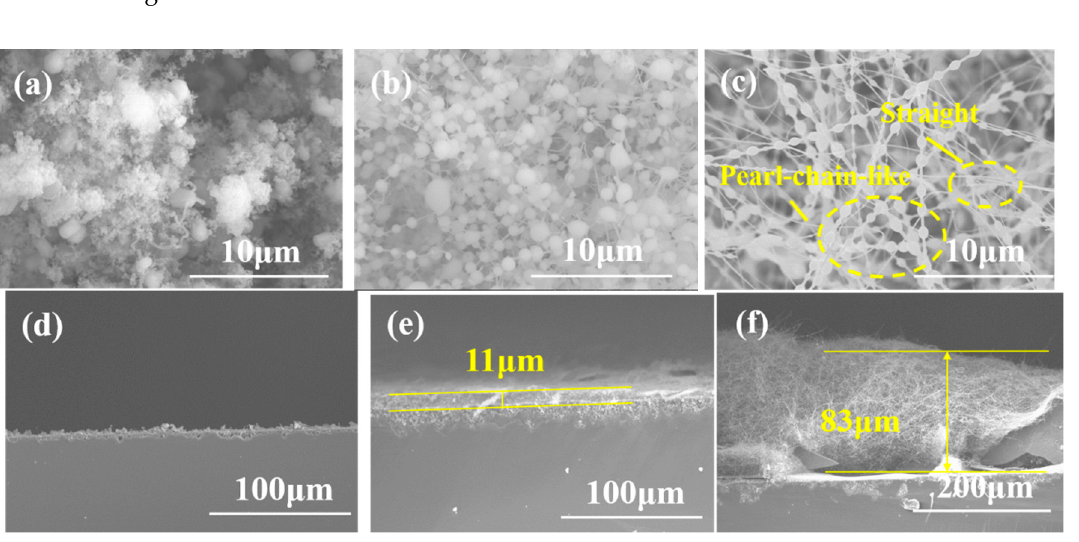
Figure 1. Surface morphology scanning electron microscopy (SEM) images of ( a ) A1, ( b ) A2, ( c ) A3 SiC nanowires, Cross-section morphology SEM images of ( d ) A1, ( e ) A2, ( f ) A3 SiC nanowires.